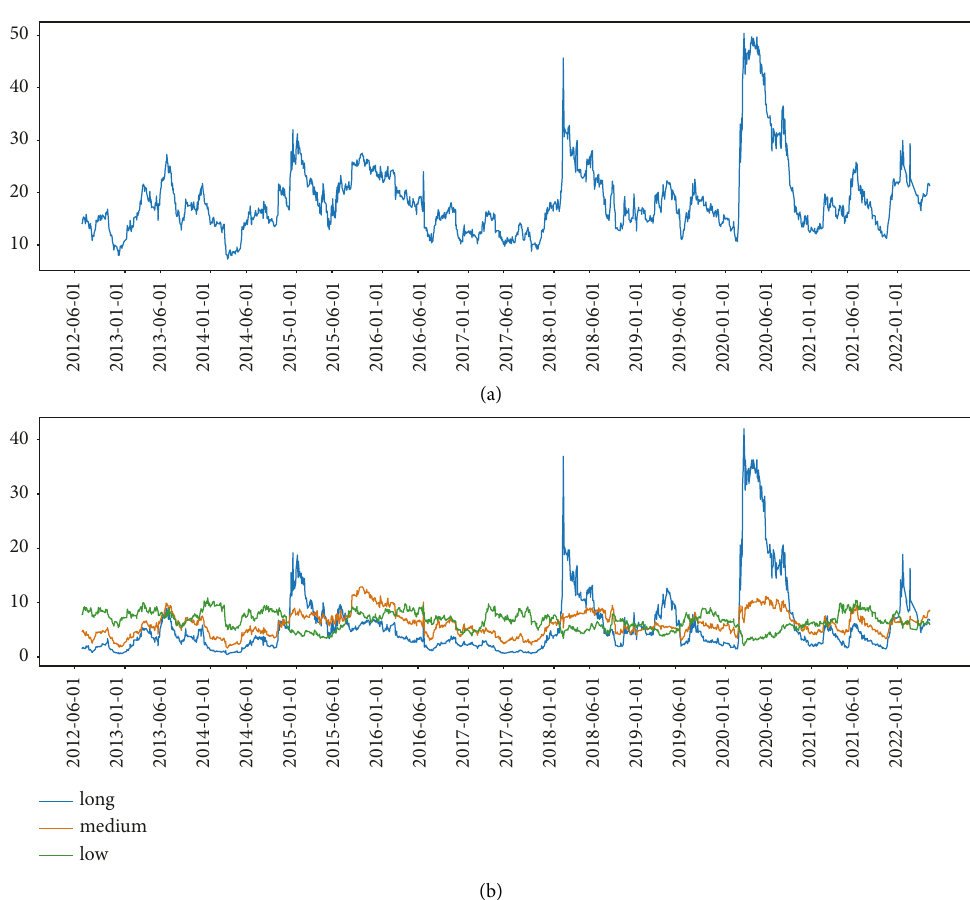
Figure 1: Total spillovers and frequency decomposition. (a) Total spillover. (b) Time-frequency decomposition of the total